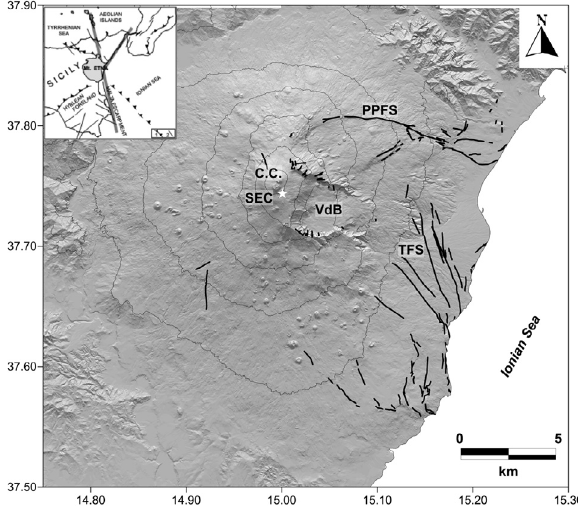
Figure 1. Schematic map of the main faults on Mt. Etna (modified from Azzaro et al. [2012]). In the inset: tectonic setting and main geological units of eastern Sicily and southern Calabria; grey lines indicate the main regional structural lineaments. PPFS = Pernicana Provenzana Fault System; C.C. = Central Craters; SEC = South East Crater; TFS = Timpe Fault System; VdB = Valle del